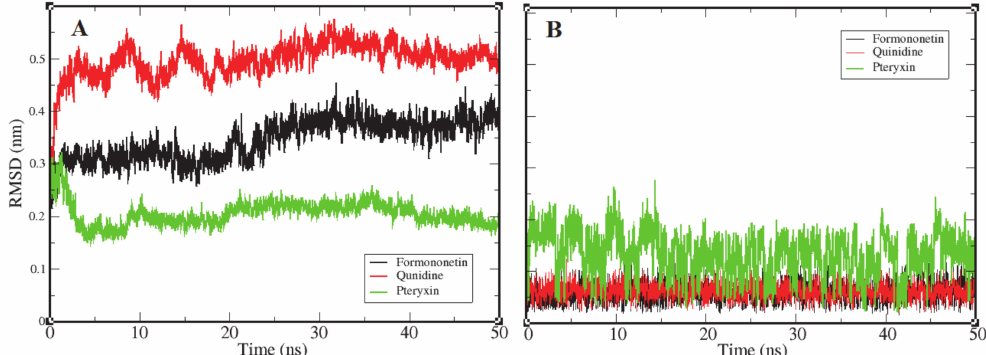
Figure 6. Representation of an RMSD plot of each complex in terms of their relationship between RMSD values and simulation time, shown in three different color codes. Panel ( A ) shows an RMSD plot of the backbone atoms of FimH protein receptor interacting with three ligand candidates, while panel ( B ) represents the RMSD plots of ligand candidates during simulation, which are color coded black (Formononetin), red (Quinidine), and green (Pteryxin). FimH protein complexes with Formononetin and Quinidine possessed high stability during simulation, while the third complex with Pteryxin demonstrated comparatively less